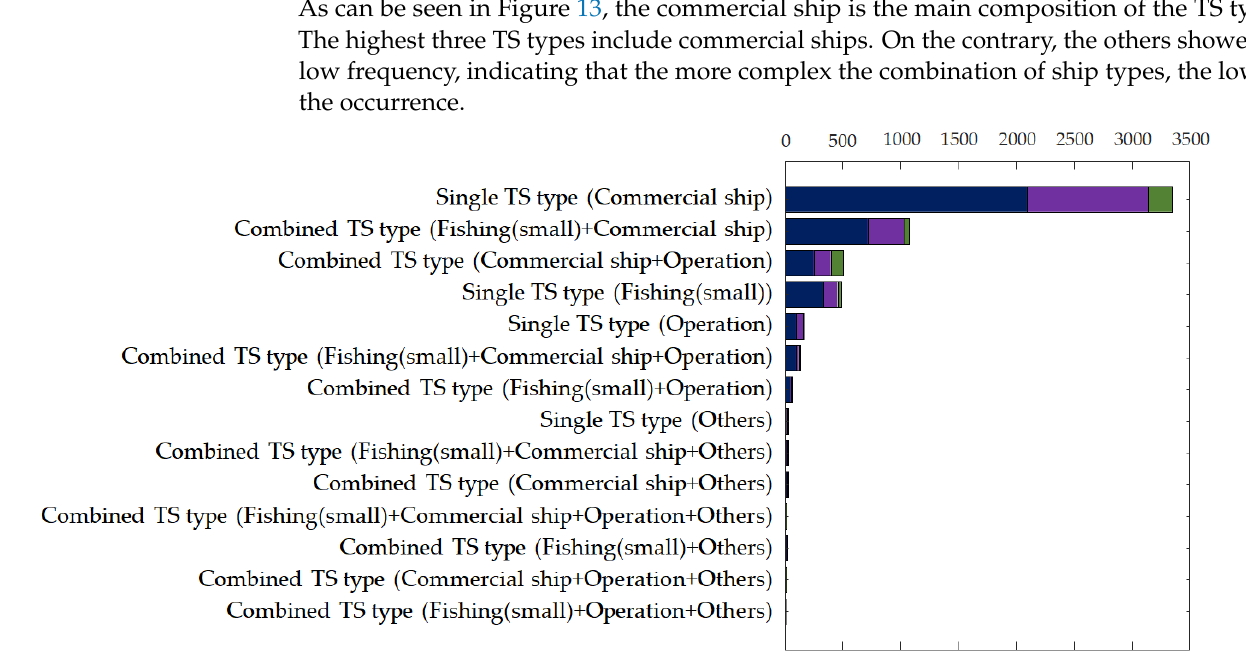
Figure 12. The ratio of clusters in the second stage cluster.